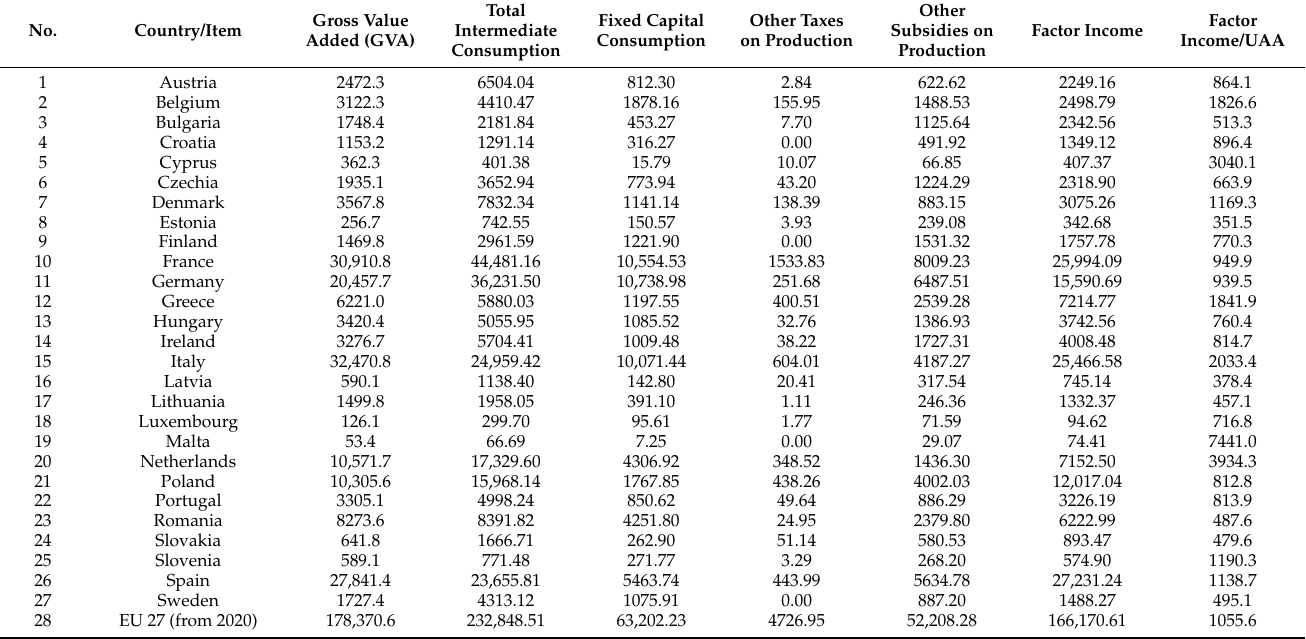
Table 10. Factor income determination using specific indicators (million euro).